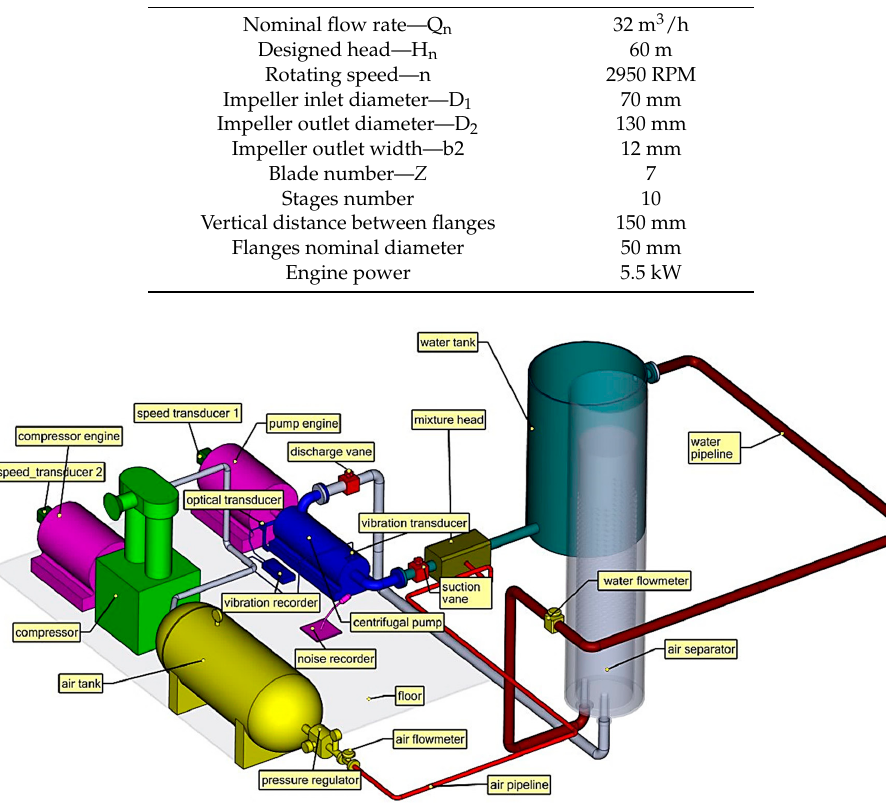
Figure 1. Experimental stand layout.